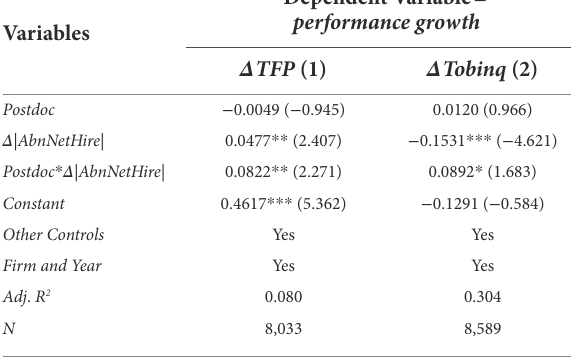
TABLE 10 Postdoctoral workstation, LIE, and performance